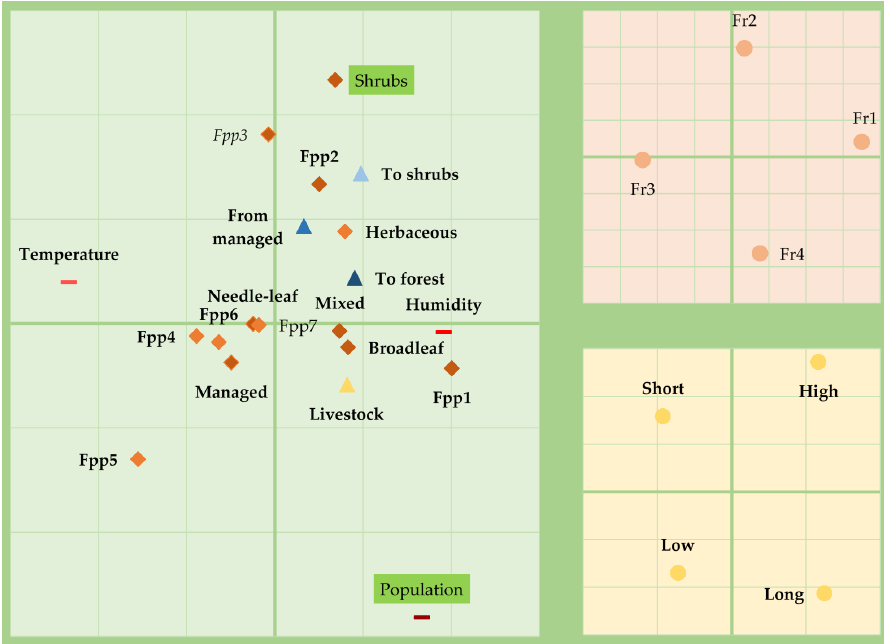
Figure 3. The RLQ scores of fire regime groups, fire regime characteristics and environmental characteristics on the first and second RLQ axes and significance of both characteristics with both axes. Fire regime groups ( upper right ; grid size: 0.5 × 0.5), fire regime characteristics ( lower right ; grid size: 0.5 × 0.5) and environmental characteristics ( left ; grid size: 0.2 × 0.2). Characteristics significantly correlated with the first RLQ axis are emphasised in bold, with the second RLQ axis in italics, with both RLQ axes in green and not significant in regular. Fire regime (Fr) groups, from 1–4. High and low density of fire activity (High and Low). Long and short seasonality of fire activity (Long and short). Environmental characteristics symbolized by a dash represent indirect gradients based on climate and humans, the rhombi represent resource gradients based on forest potential productivity and land cover and triangles represent indirect gradients based on livestock grazing and land cover changes. Population density (Population), Seasonal temperature fluctuation (Temperature), Forest potential productivity (Fpp) categories, from 1–7. Cultivated and managed vegetation/agriculture (incl. mixtures) (Managed). Livestock density (Livestock).